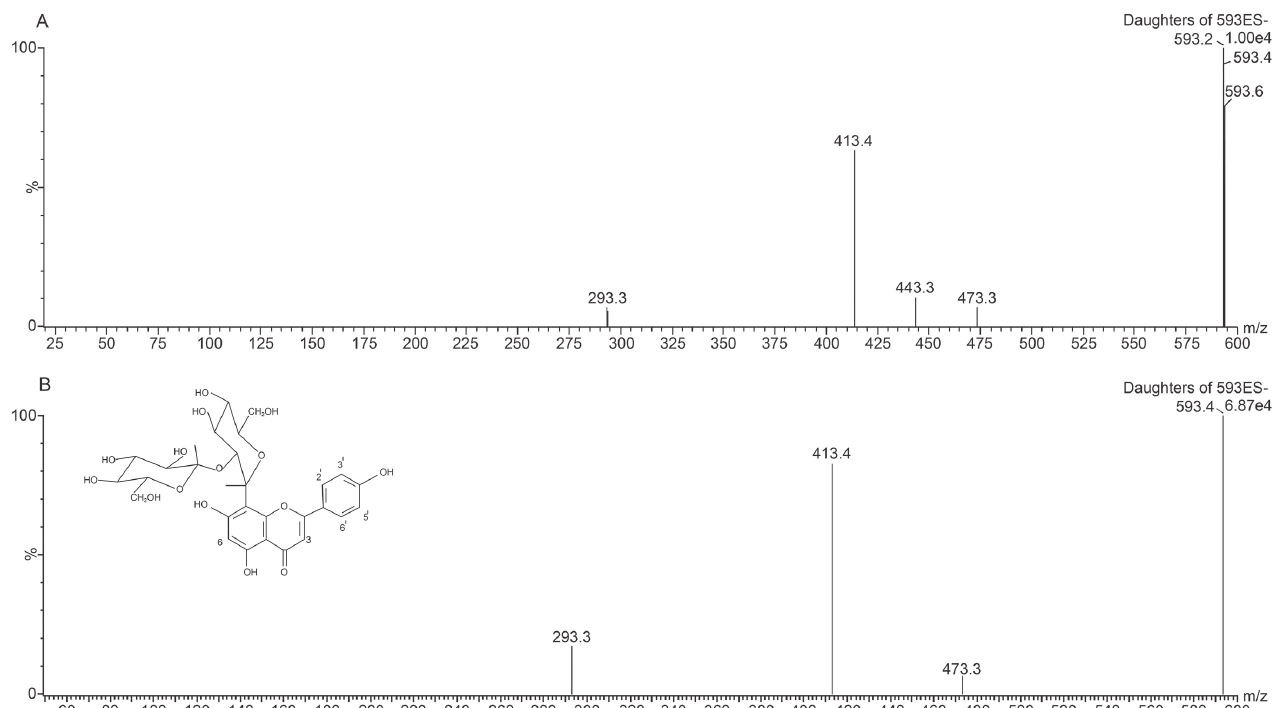
FIGURE 4 - ESI(-)-MS/MS. A) Fragmentation of peak 593 m/z of P. coccinea (Aubl.) methanolic extract. B) Fragmentation of 2”-O- β -D-glucopyranosyl-vitexin. For conditions, see material and